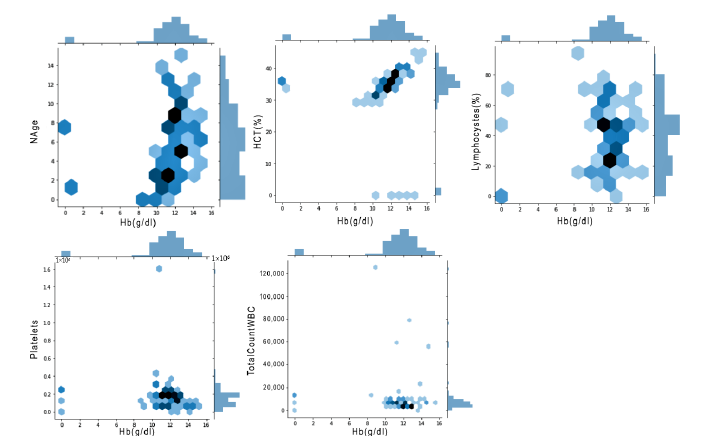
Figure 4. Bi-variant Relation between different features of the BDengue